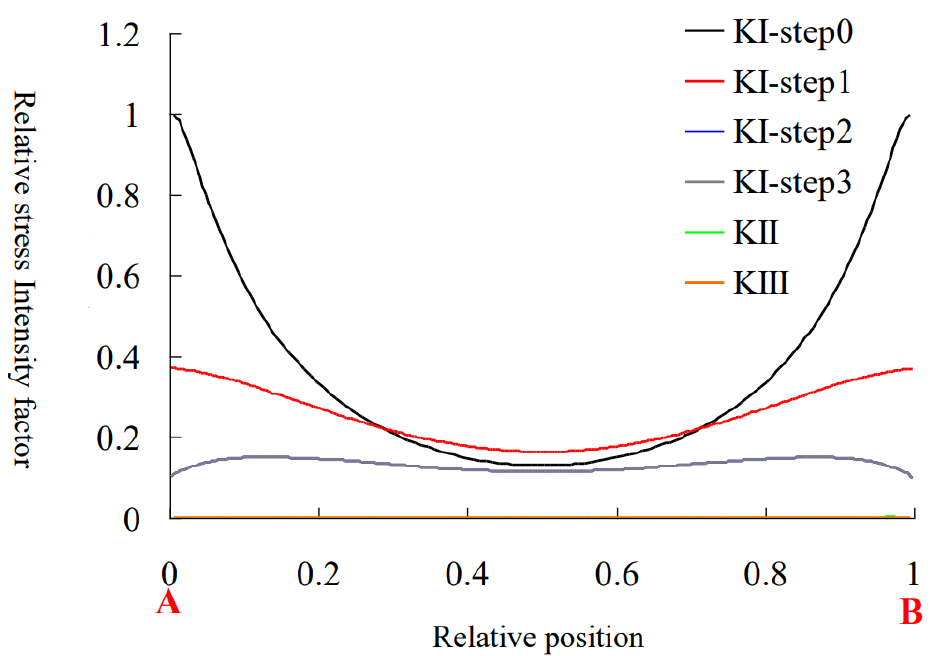
Figure 18. Variation of stress intensity factor at the tip of the main crack. A and B are the start and end point of the crack front.